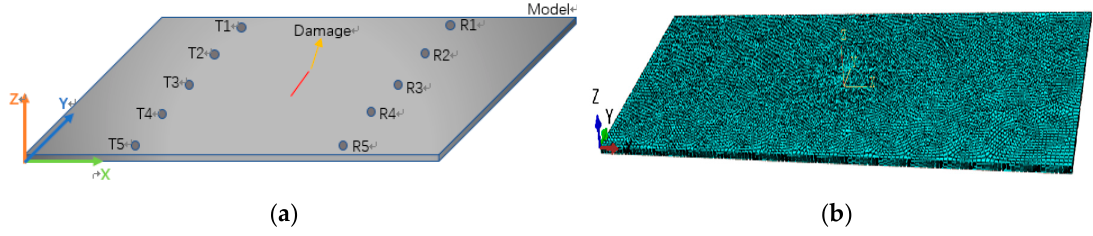
Figure 8. Simulation model: ( a ) Schematic diagram of ABAQUS simulation model; ( b ) ABAQUS simulation model.